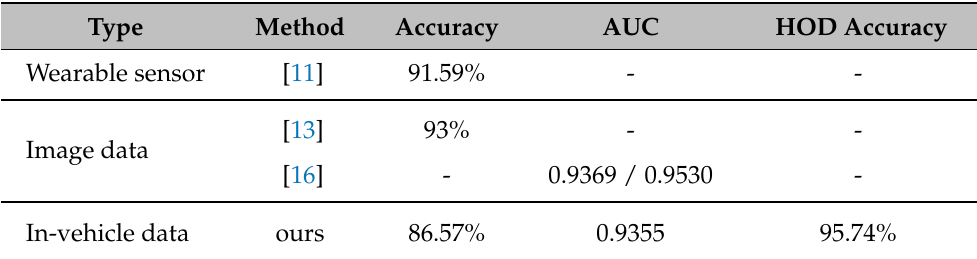
Table 8. Comparing the performance of some methods. Ref. [16] suggested AUC for left/right hand, respectively. All figures were cited from their papers.